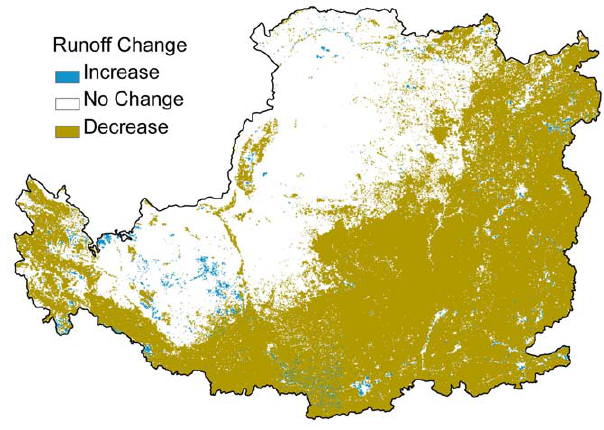
Figure 5. Average water yield change due to land cover change from 2000 to 2008.